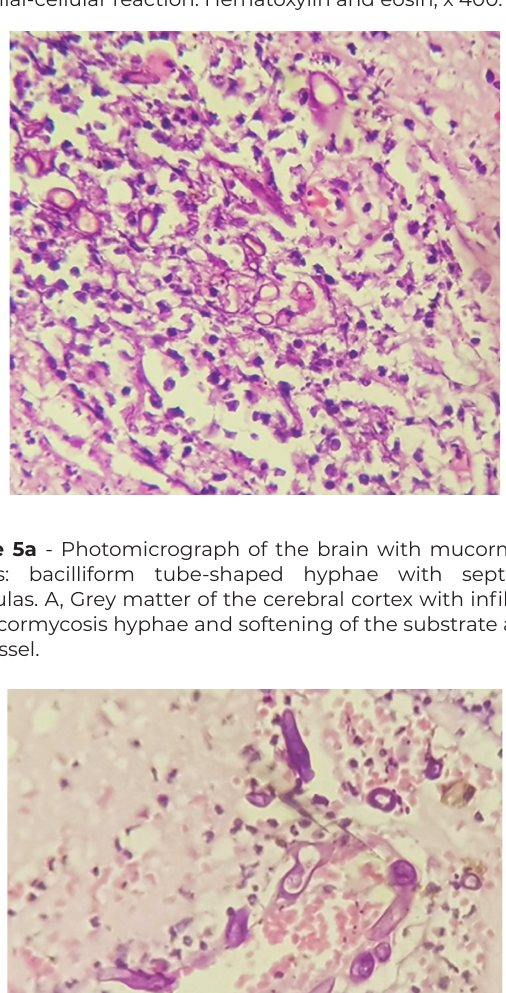
Figure 4a - Grey matter lesion of the cerebral cortex with mucormycosis. A, Massive accumulation of mucormycosis bacilli with glial-cellular reaction. Hematoxylin and eosin, x 400.